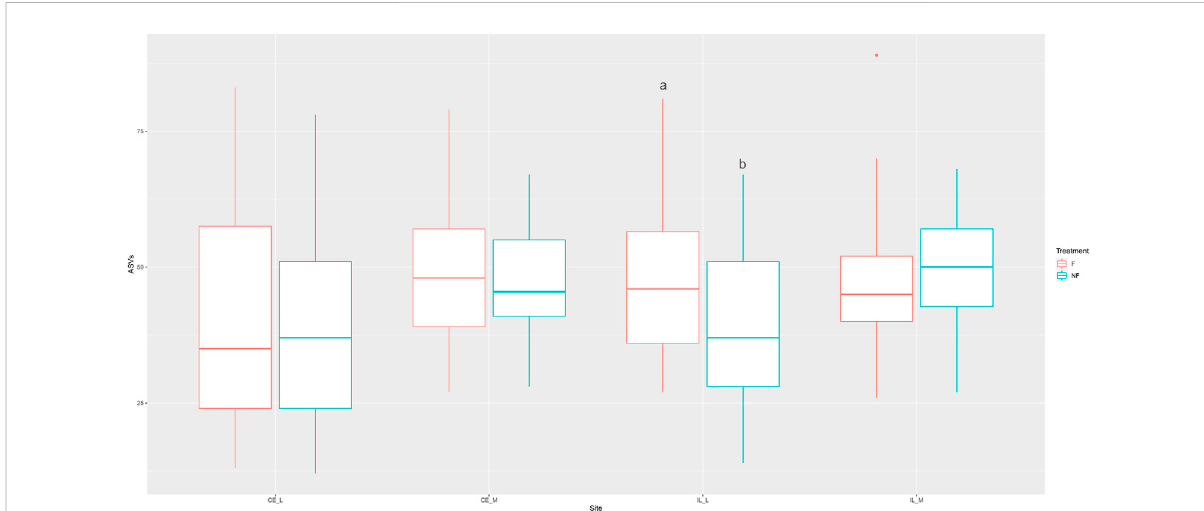
FIGURE 1 Boxplot of the number of ASVs observed across all four sites (CE_L = cecal lumen, CE_M = cecal mucosa, IL_L = ileal lumen, IL_M = ileal mucosa) infed and unfed chicks.The number of ASVs wasnot signi fi cantly different atany siteexcept for theileal lumen, where agreater number of ASVswasobservedinfedcomparedtounfedchicks.Boxrepresentstheinterquartilerange,withtheloweredgeofbox=25%percentile,upperedge of box = 75% percentile, the midline = the median, and upper whisker = the largest value within 1.5 times the interquartile range above 75% percentile,lowerwhisker=thelargestvaluewithin1.5timestheinterquartilerangebelow25%percentile.Dotsrepresentoutliers.Meansnotsharing any letter are signi fi cantly different by the Tukey-test, alpha = 0.05.